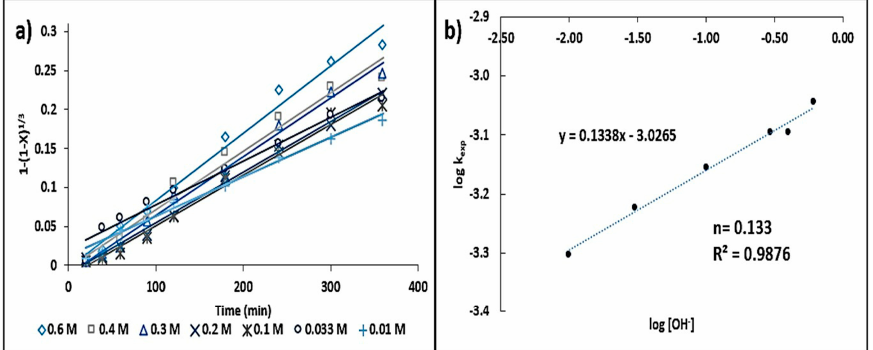
Figure 9. ( a ) Evaluation of the chemical control model in the Ag conversion values as function of time in order to the [OH − ] concentration effect. V = 0.5 L, Mineral = 40 g · L − 1 , P O2 = 1 atm, pH = 9.0, t r = 360 min, d = 74 µ m, [S 2 O 32 − ] = 0.5 mol · L − 1 , T = 298 K, RPM = 670 min − 1 . ( b ) Dependence of log k exp as a function of log [OH − ].